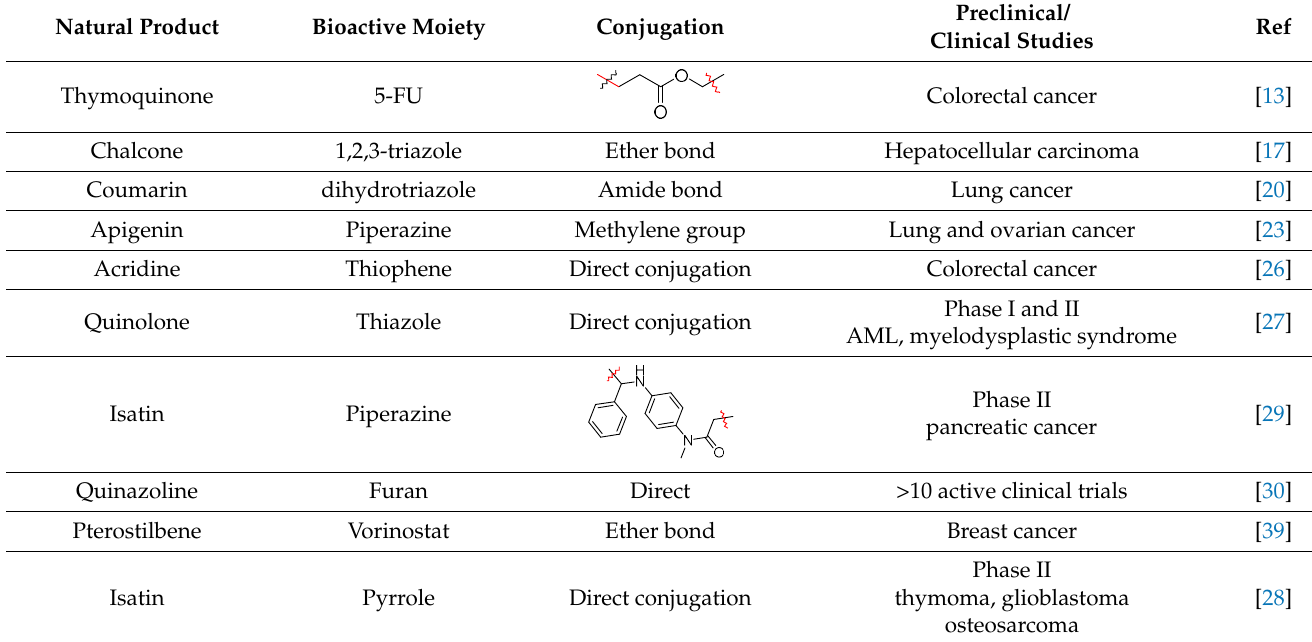
Table 1. Natural product-based hybrids commented in this work.